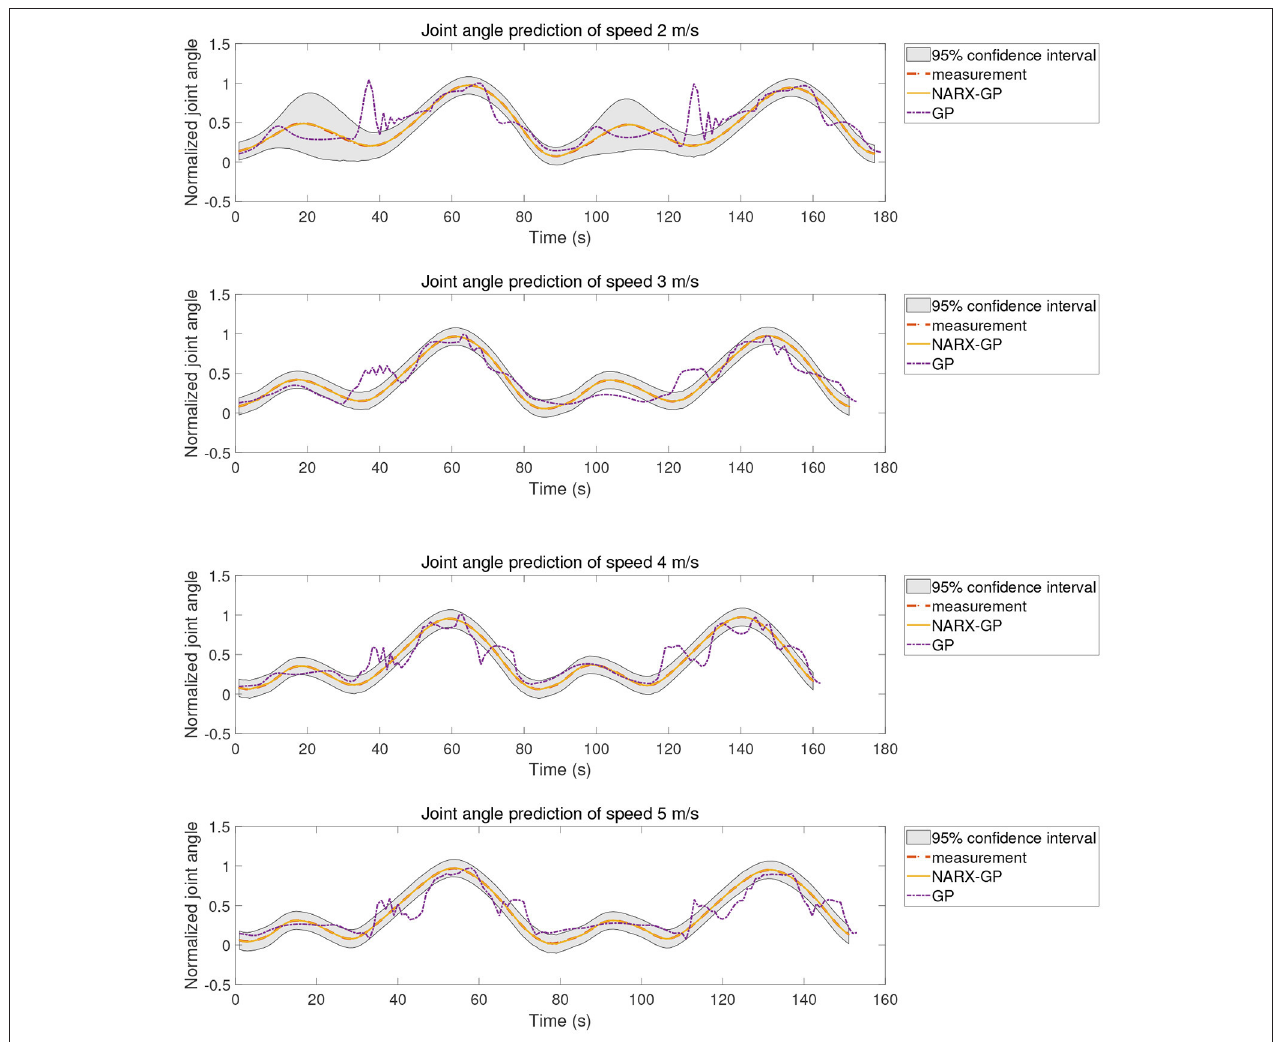
FIGURE 8 | Joint angle prediction under speed-independent of subject